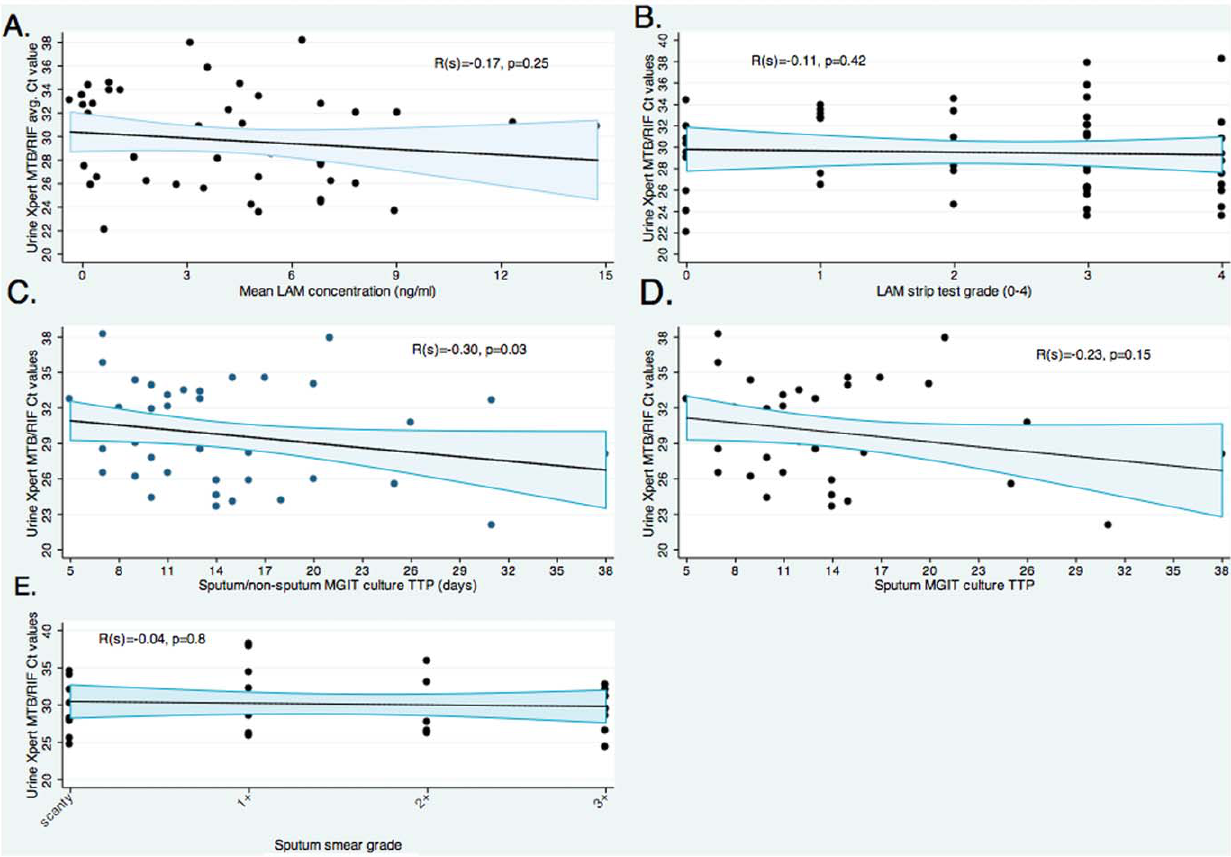
Figure 3. Urine-based MTB/RIF-generated C T values correlates with other markers of bacillary burden. In m.tb culture and urine MTB/ RIF positive patients, MTB/RIF-generated C T values were correlated with (A) urine LAM ELISA concentration, (B) urine LAM strip grading, (C) either sputum or non-sputum liquid culture time-to-positivity (TTP), (D) only sputum liquid culture time-to-positivity, and (E) smear-grade in smear positive patients.